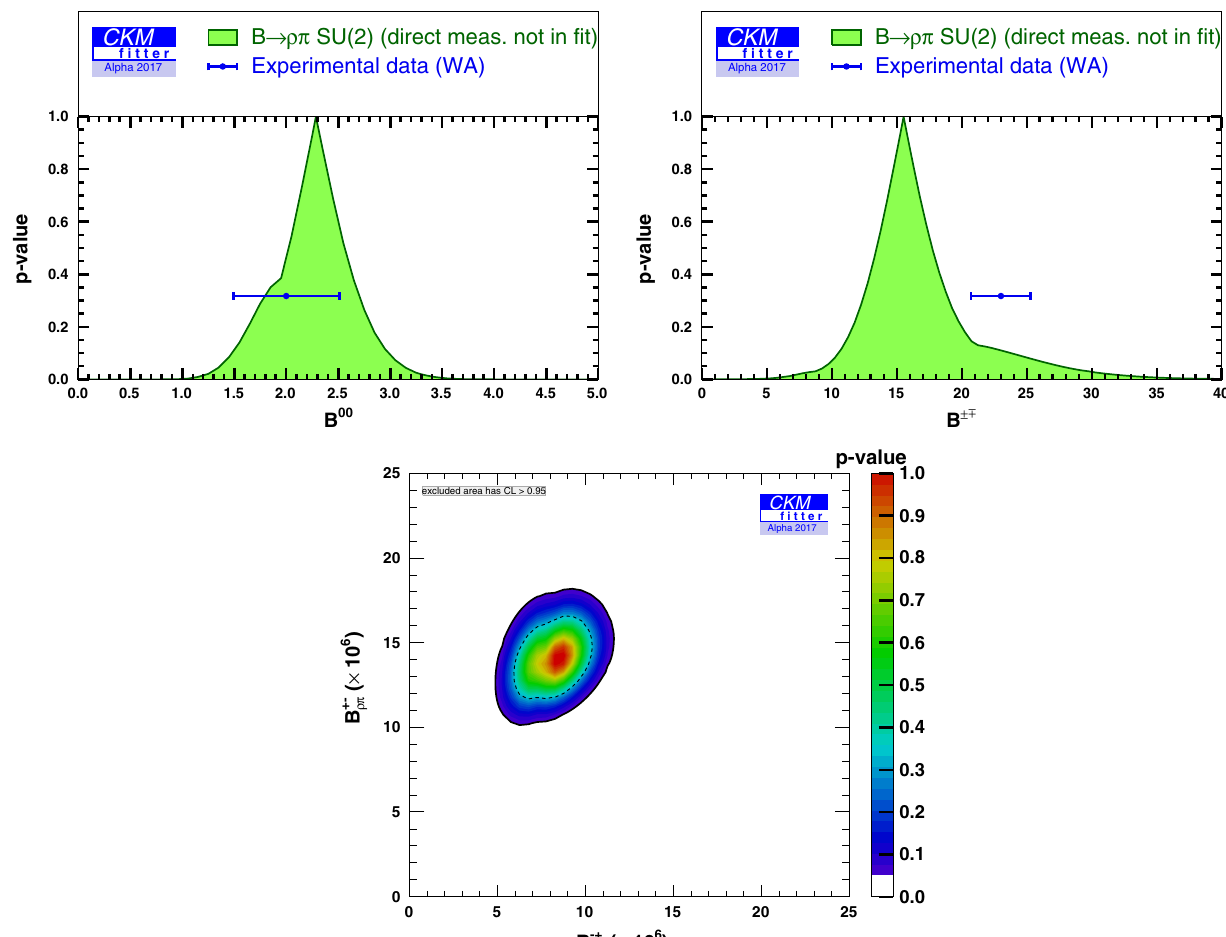
Fig. 39 Constraintonthebranchingfractionoftheneutral B 0 → ρ 0 π 0 mode ( top , left ) and the mixed B 0 → ρ ± π ∓ mode ( top , right ). The direct measurement, not included in the fit, is indicated by an interval